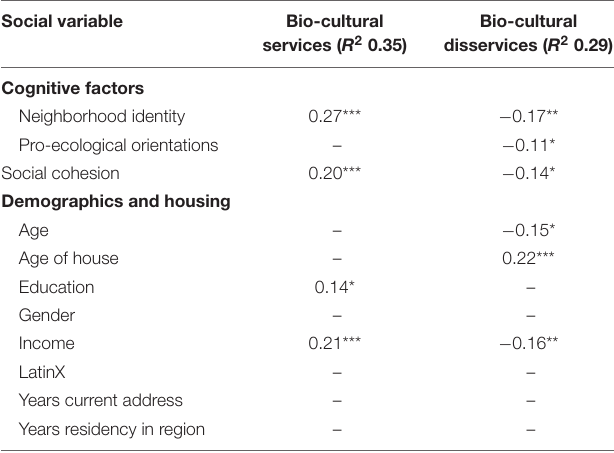
TABLE 7 | Social model results for predicting perceptions of bio-cultural services and